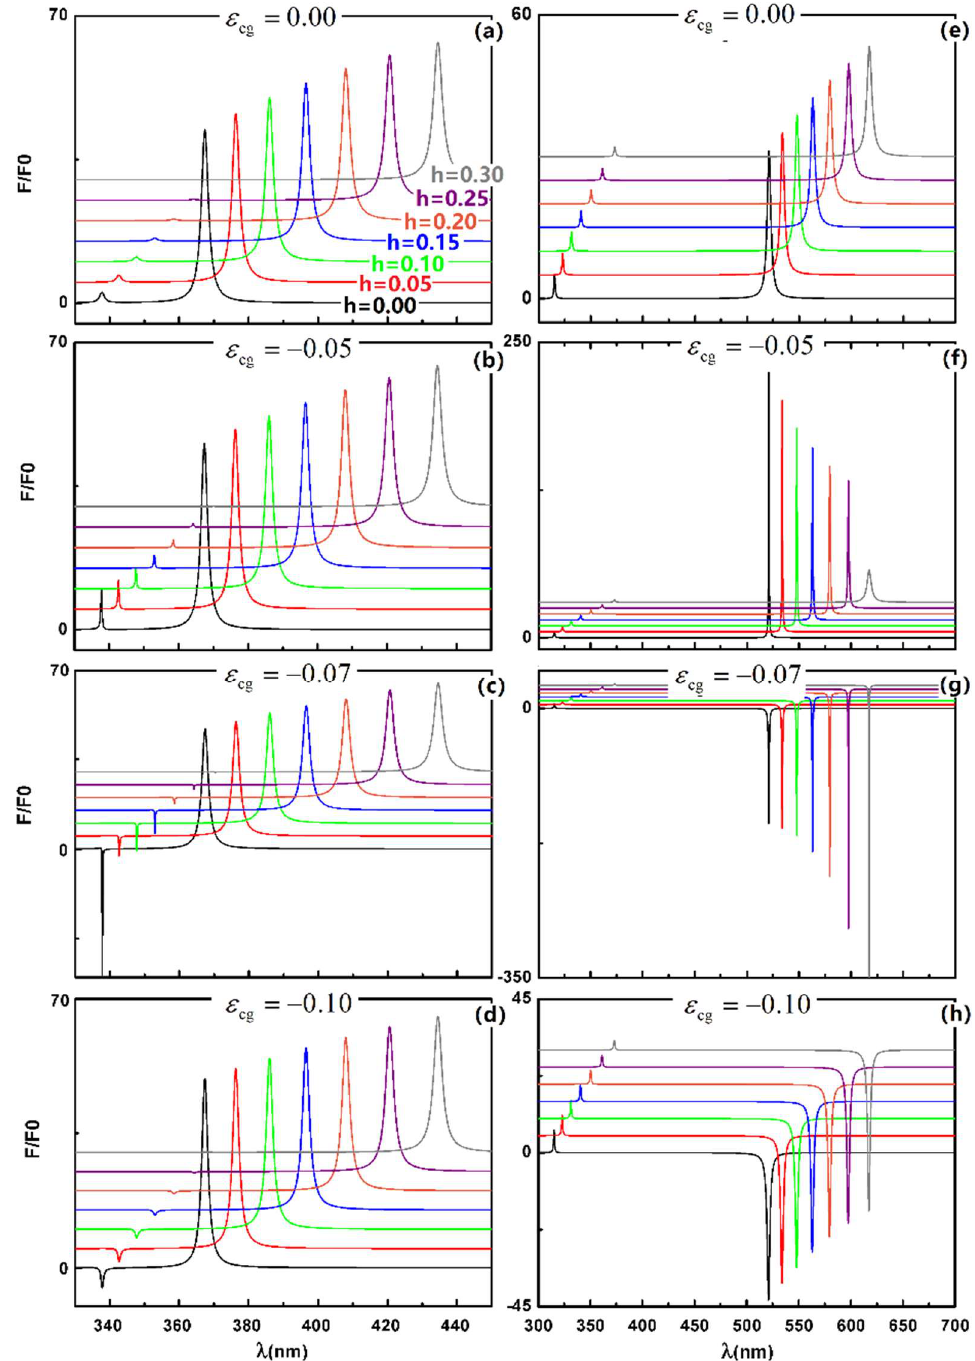
Figure 2. Normalized time-averaged optical force as a function of the incident wavelength λ for low aspect ratio, a / b = 0.2 ( a – d ), and high aspect ratio, a / b = 0.8 ( e – h ) with different gain coefficients ε cg and gradient coefficients h . Other parameters are b = 10 nm and k = 0.4. For the normalization F 0 = π b 2 S inc / c ( S inc is the power flow density of the incident wave) is used.